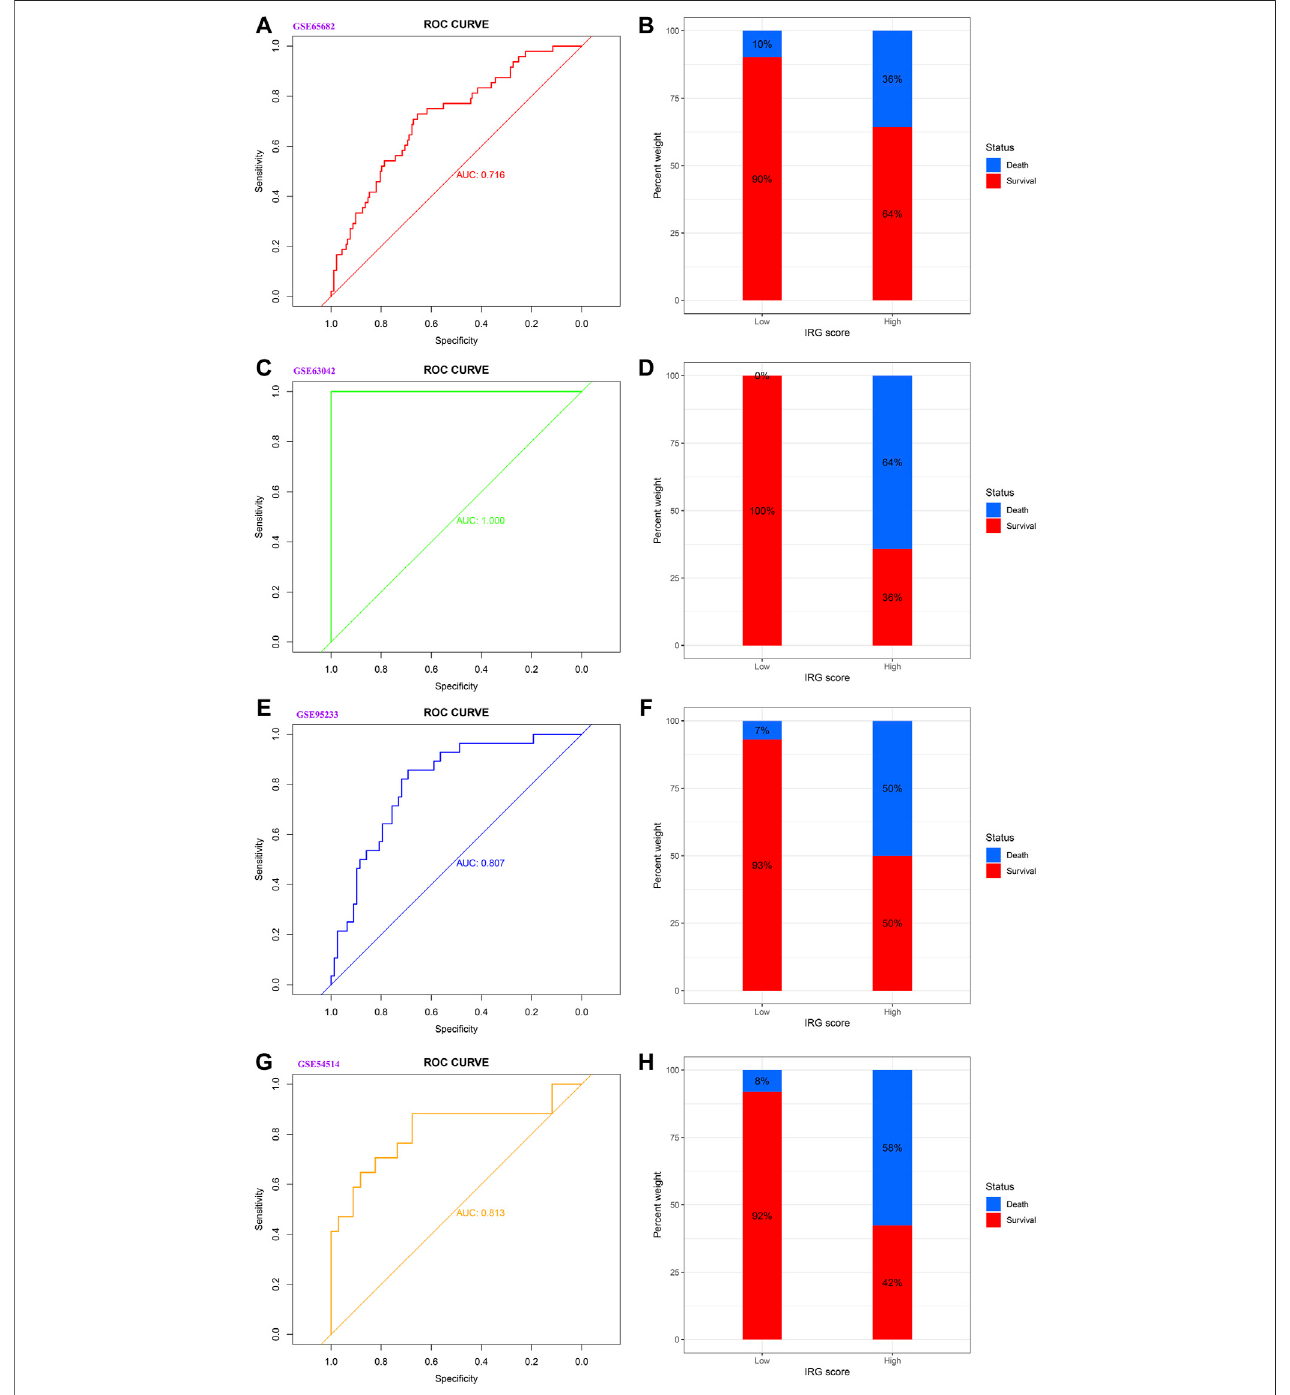
FIGURE3| TheprognosticcapacityoftheHLAclassi fi erandthedistributionofmortalityrateindifferentHLAsubgroupsinthediscoverycohorts. (A,B) GSE65682 datasets. (C,D) GSE63042 datasets. (E,F) GSE95233 datasets. (G,H) GSE54514 datasets.